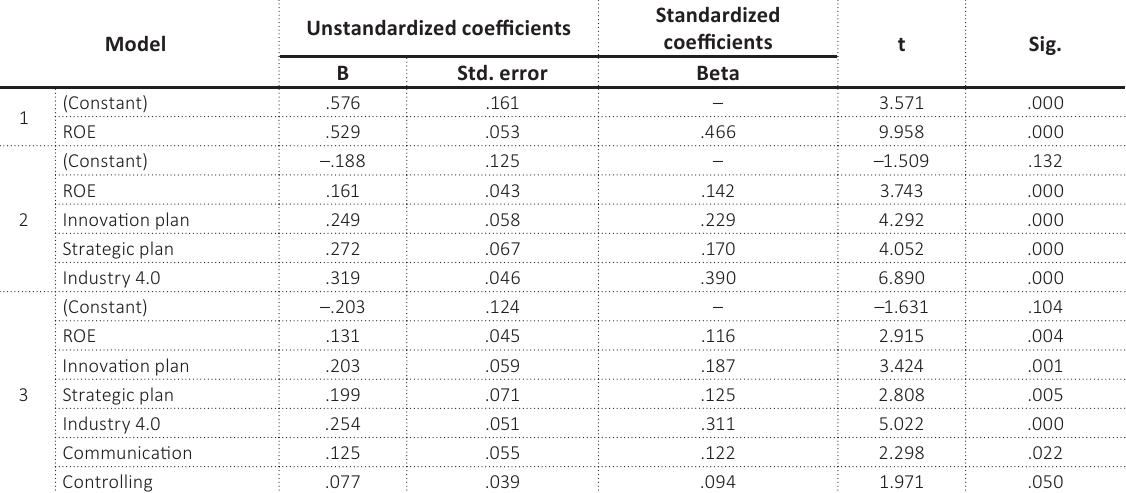
Table 3. Inclusion in the final model of dependent variable Social